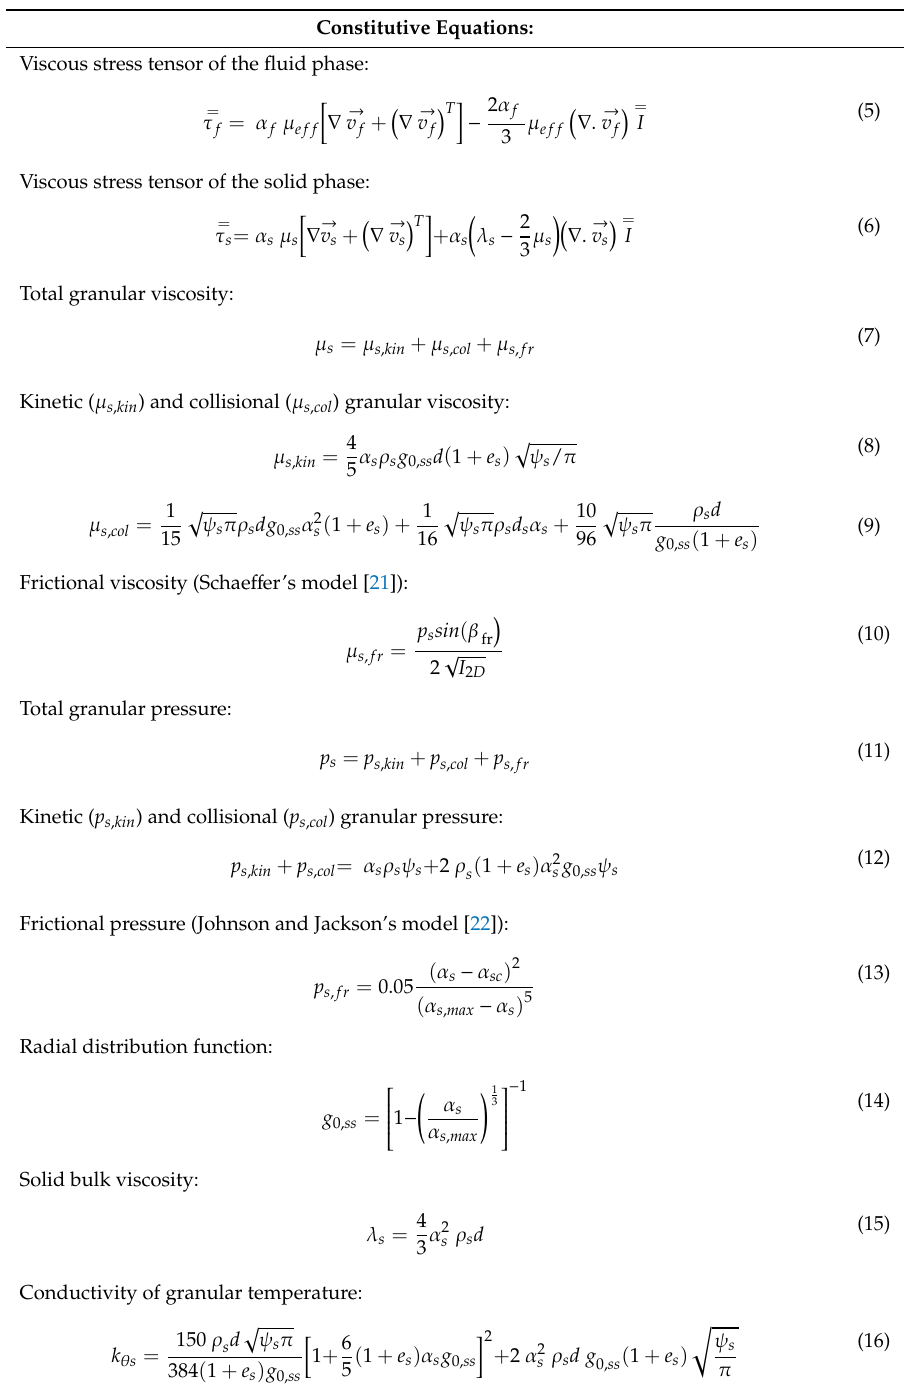
Table 2. Constitutive equations for the Euler–Euler approach